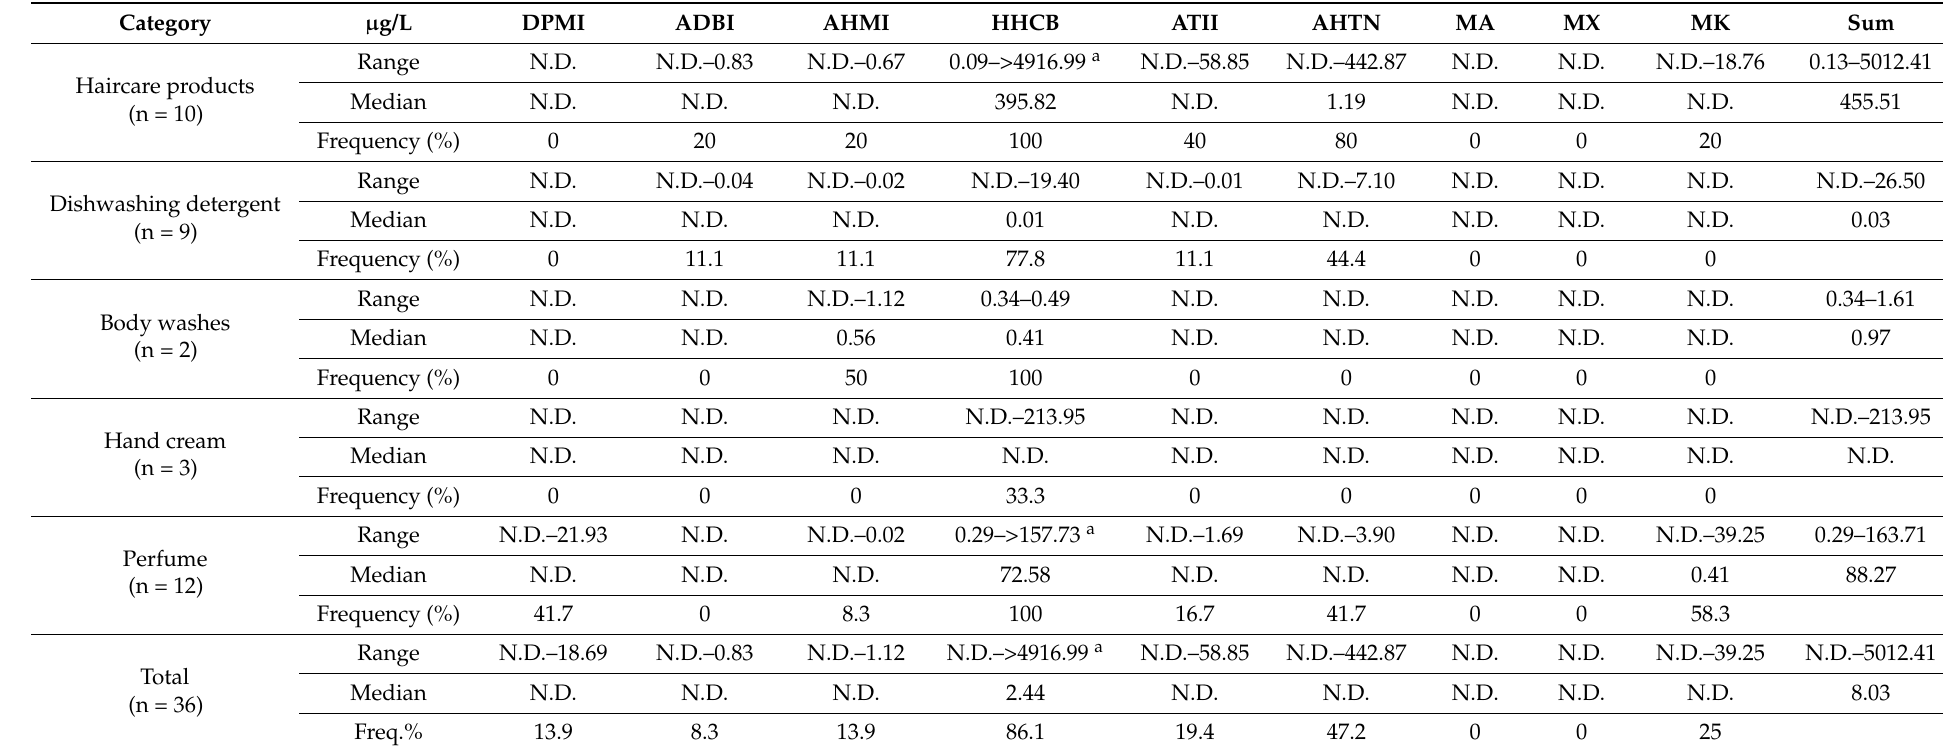
Table 2. Concentration ( µ g/g) and detection frequency (%) of synthetic musk fragrances in personal care products.